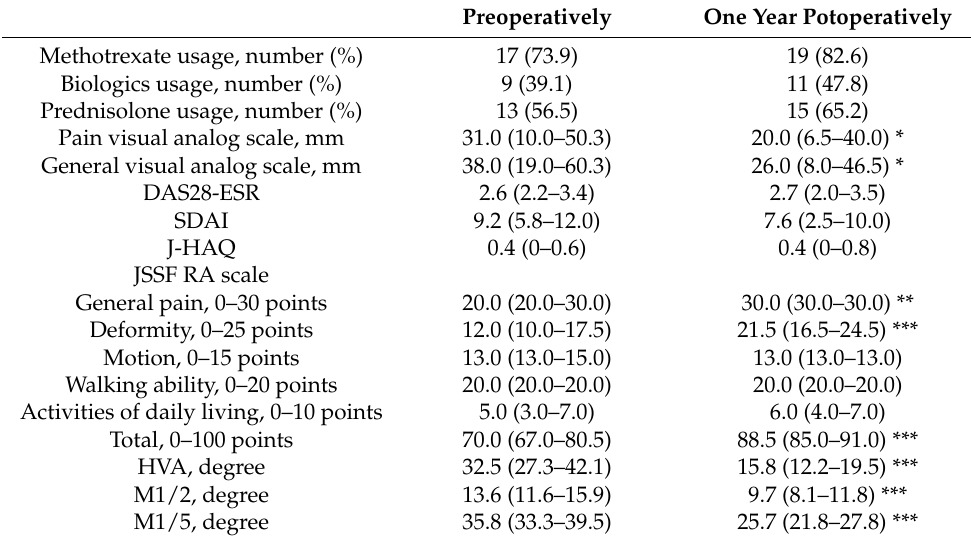
Table 2. Patient background